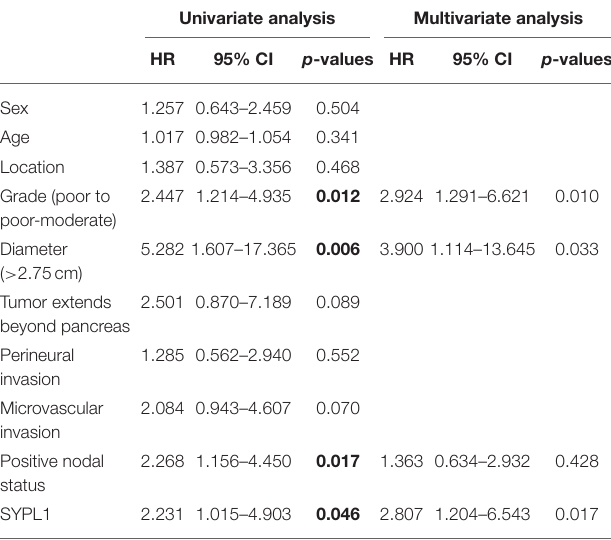
TABLE 2 | Univariate and multivariate Cox regression analysis for patients from Sun Yat-sen University Cancer